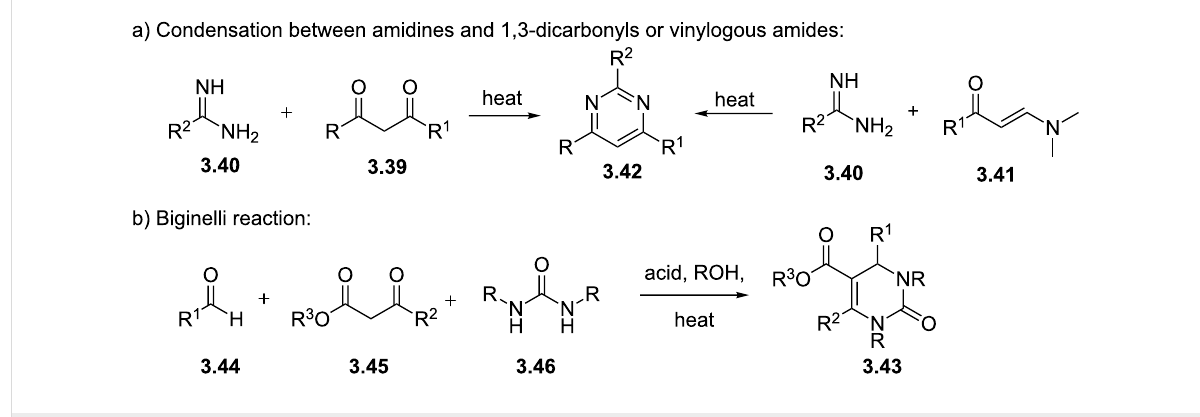
Scheme 36: General preparation of pyrimidines and